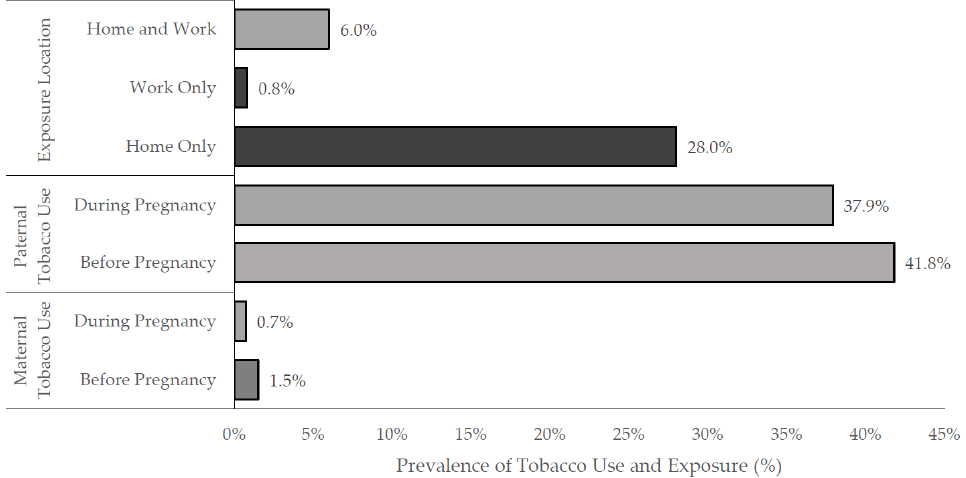
Figure 1. Prenatal tobacco exposure and self-reported parental tobacco use amongst 8586 pregnant women in Al Ain, UAE. The Mutaba’ah Study. Table 1. Demographic characteristics of 8586 pregnant women stratified by their ETS exposure in Al Ain, UAE: The Mutaba’ah Study.